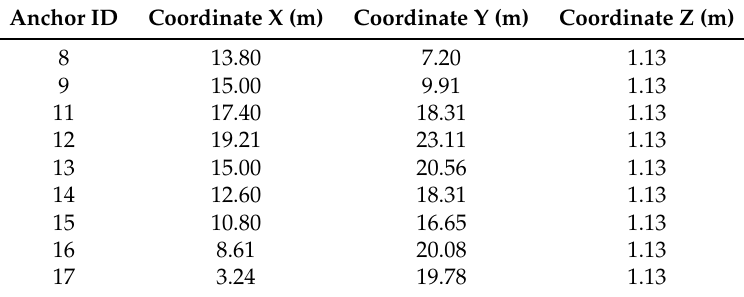
Figure 6. RMSEs of different algorithms using different means of NLOS error. Table 2. The list of the locations of anchor